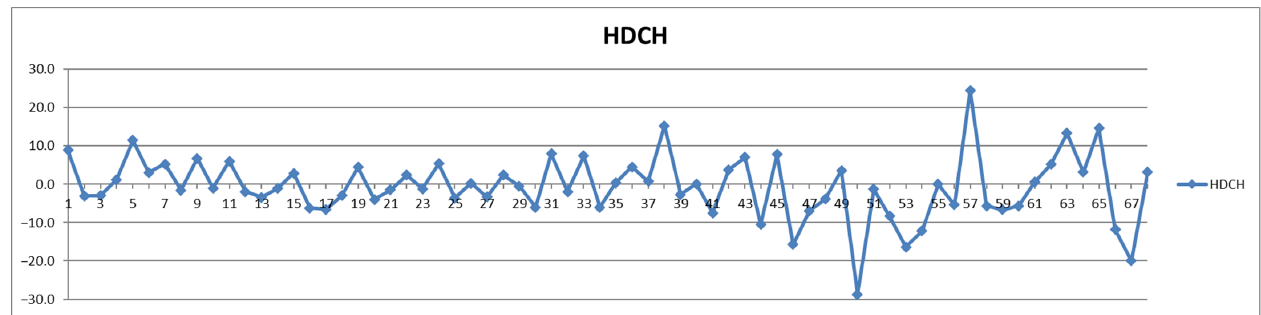
Figure 15. The food intake effect on HDL cholesterol (HDCH) as difference between postprandial